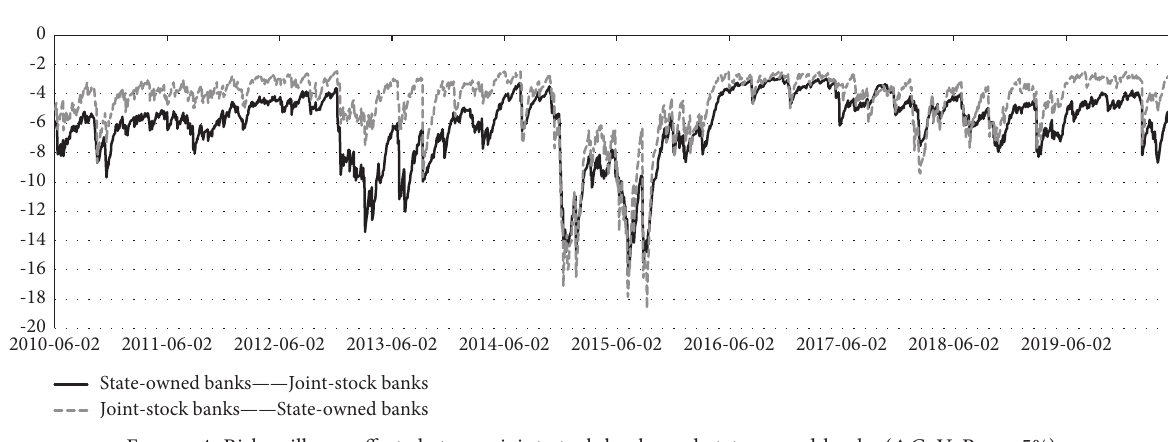
Figure 3: Risk spillover effects between city commercial banks and state-owned banks ( △ CoVaR, α � 5%).